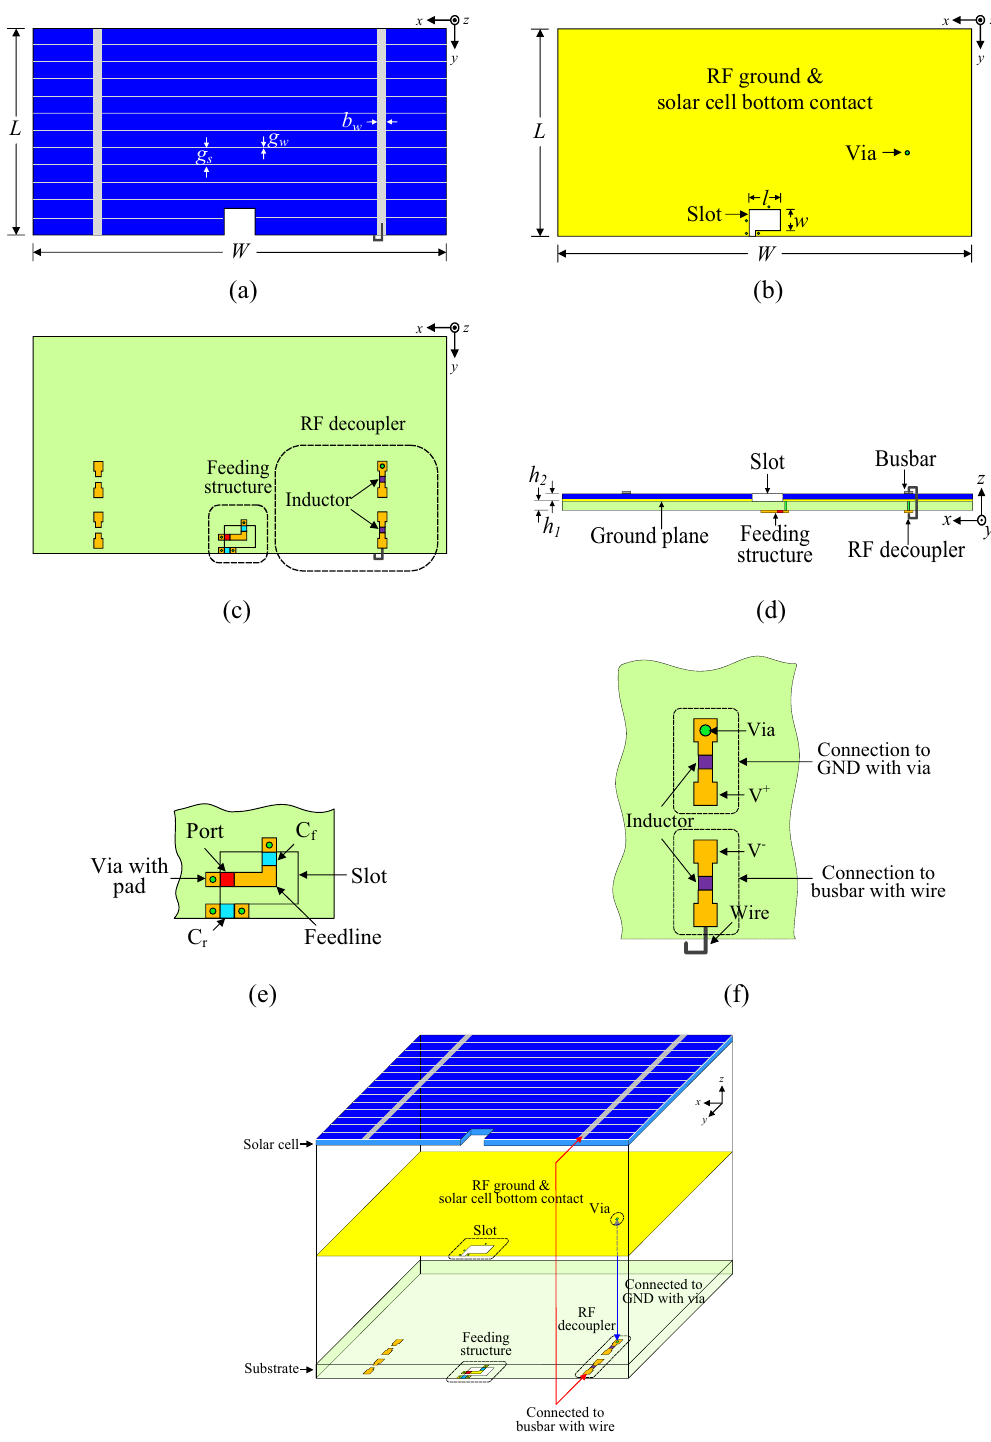
Figure 1. Geometry of the solar-cell-integrated antenna: ( a ) top view, ( b ) top view of bottom contact of the solar cell, ( c ) top view of the bottom side, ( d ) side view, ( e ) extended view of feeding structure with the slot, ( f ) extended view of RF decoupler circuit, and ( g ) 3D